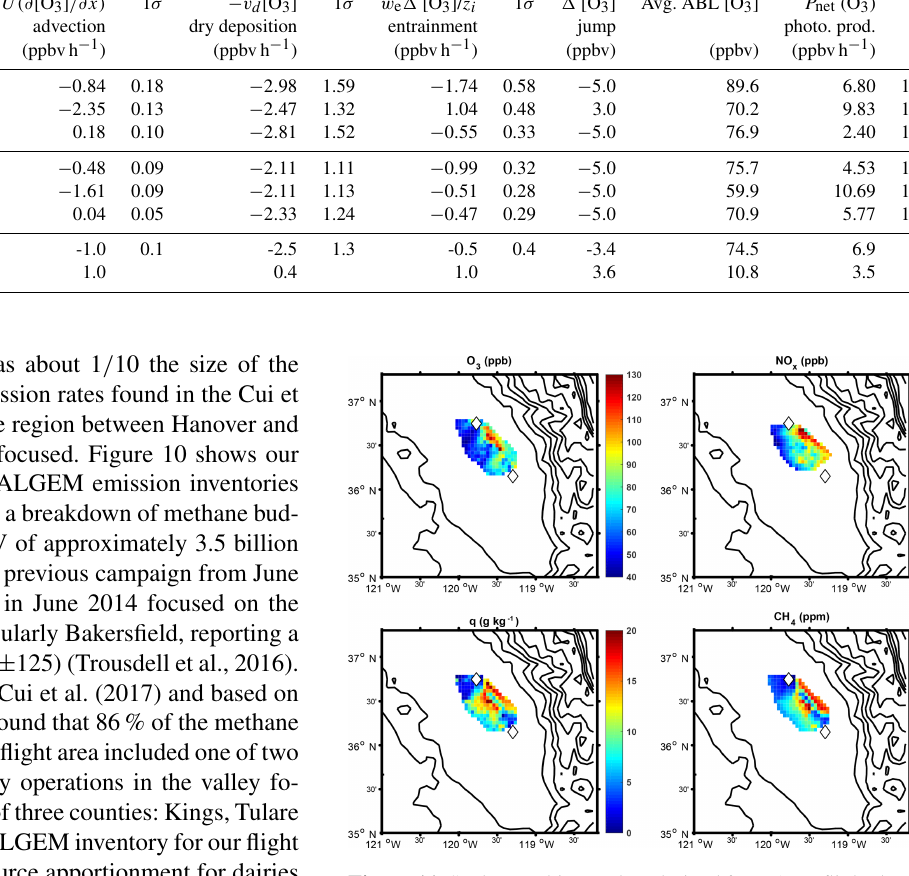
Figure 11. Scalar patchiness plots derived from ABL flight data cor- rected to a common time and height stamp with linear interpolation between data points within the flight domain. The white diamonds are Fresno and Visalia to the north and south of the area, respec- tively. Data taken from 27 July